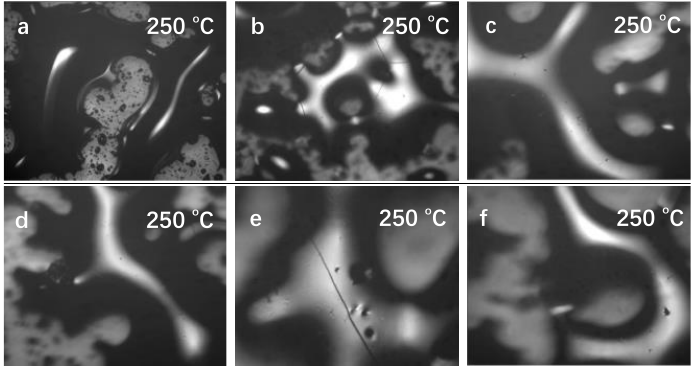
Figure 15. Diagram of the molten state of the spinnable pitch. ( a ) R − 0, ( b ) R − 30, ( c ) R − 60, ( d ) R − 90, ( e ) R − 120, and ( f ) R − 150.